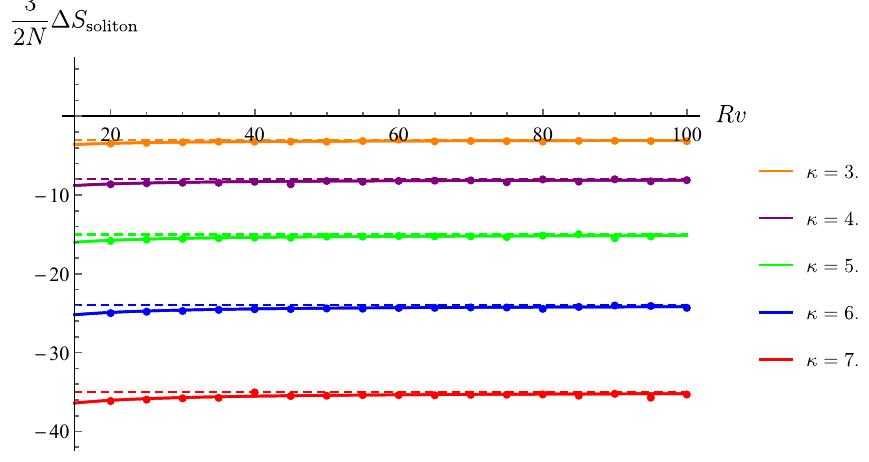
Figure 8 . The dots are our numerical results for ∆ S soliton in eq. (4.56), divided by 2 N/ 3 , as a function of Rv and for κ = 3 (orange), 4 (purple), 5 (green), 6 (blue), 7 (red). The solid lines are the prediction from eq. (4.55). The horizontal dashed lines show the limit lim Rv →∞ ∆ S soliton = − κ 2 + 2 κ